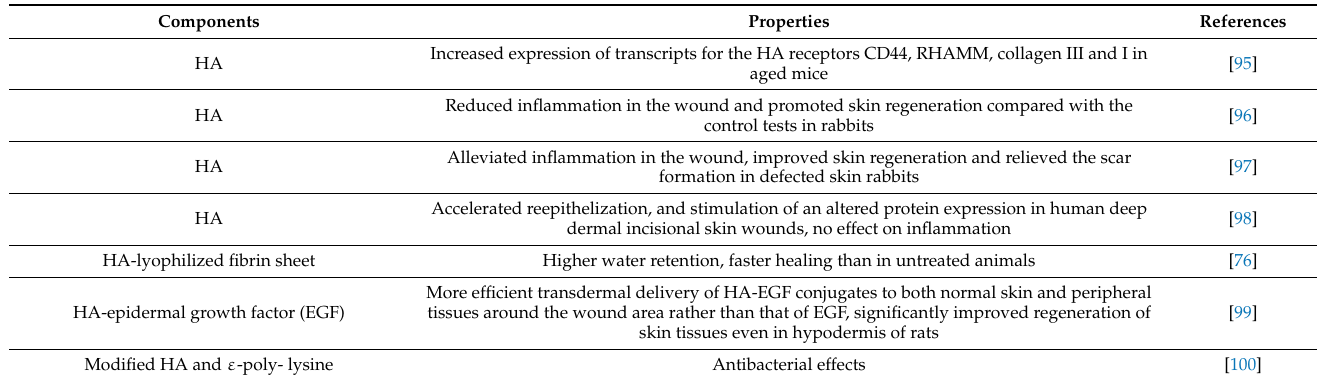
Table 1. Wound dressings for treatment of skin wounds composed of HA alone or with another component.